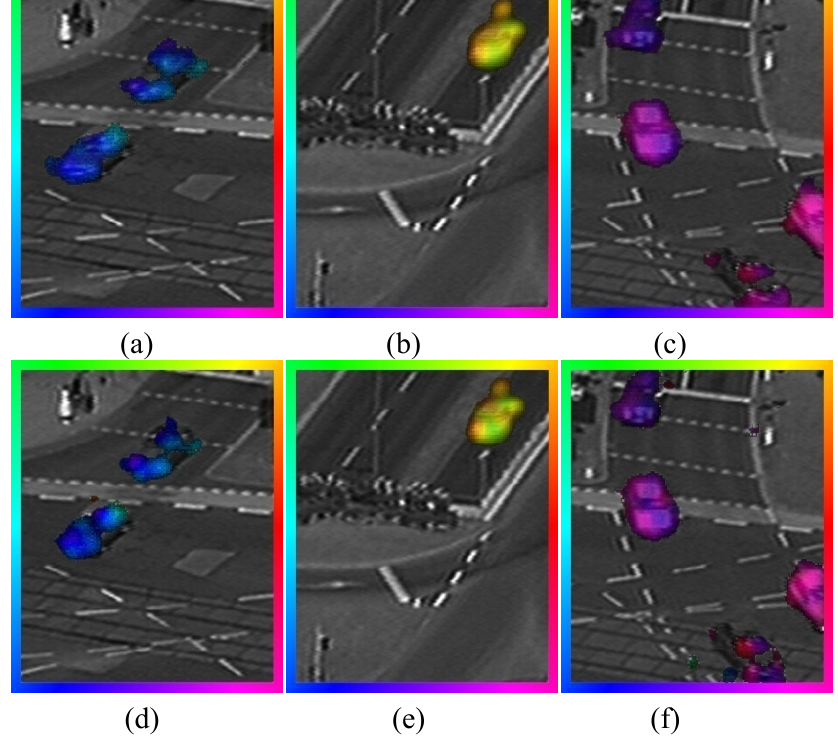
Figure 12. Optical flow estimation, on edges, in a traffic sequence. The average edge density, in these images, is 42.5%. Flow field is overlaid with the original frame. In the first row (a–c), the optical flow is estimated using 9 × 9 SIB. In the second Row (d–f), the optical flow is estimated using 5 × 5